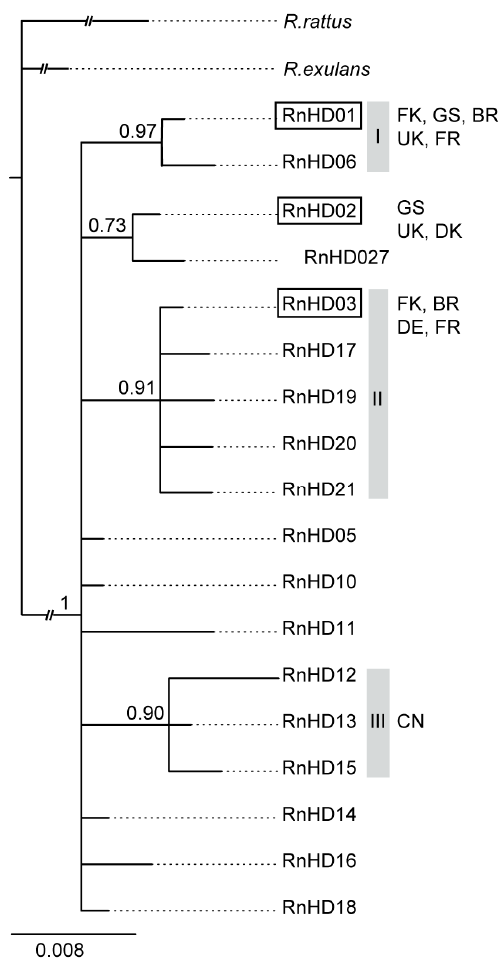
Figure 2. Bayesian consensus tree derived from 18 mtDNA D-loop haplotypes of R. norvegicus , rooted by R. rattus and R. exulans (broken lines indicate shortening of branches for better fit). Haplotypes from the South Atlantic highlighted by boxes, with locations in this study and highest abundance outside of the Atlantic indicated by ISO 3166-2 code (http://www.iso.org/iso/country_codes), also refer to legend in Figure 3. Posterior probabilities (PP) > 0.7 are shown on branches, clades with PP > 0.9 highlighted by numbered grey bars. Scale bar indicates number of substitutions per site.